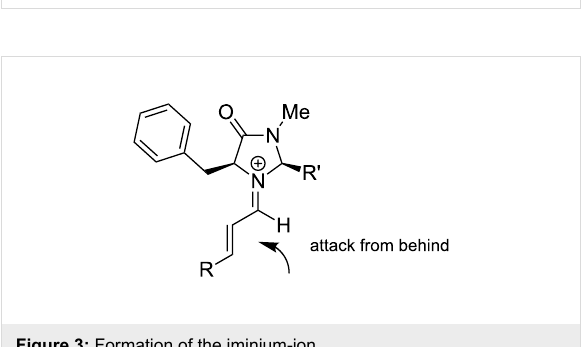
Figure 3: Formation of the iminium-ion.